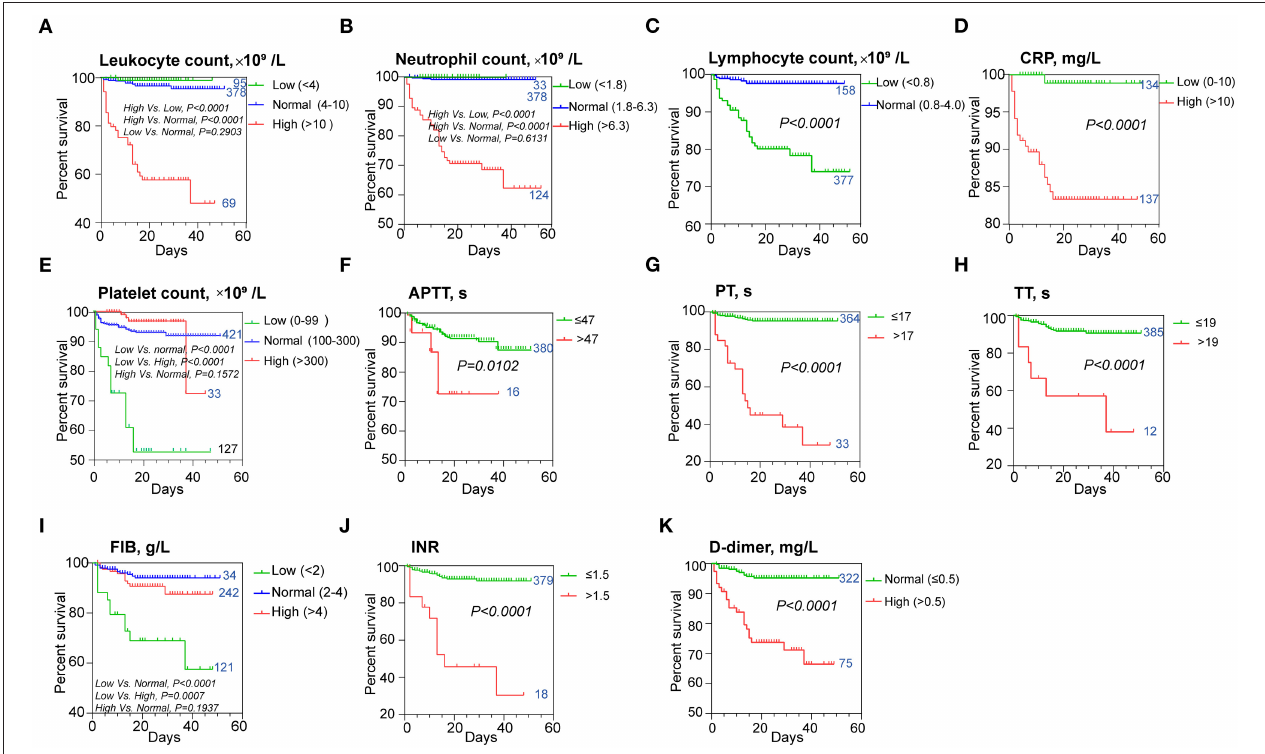
FIGURE 2 | Kaplan–Meier survival curves for different prognostic factors. The curves according to (A) leukocytes, (B) neutrophils, (C) lymphocytes, (D) CRP levels, (E) platelets, (F) APTT, (G) PT, (H) TT, (I) FIB levels, (J) INR, and (K) D-dimer levels. The patient number of each group was indicated next to the curve. CRP, C-reactive protein; APTT, activated partial thromboplastin time; INR, international normalized ratio; PT, prothrombin time; TT, thrombin time; FIB, fibrinogen.